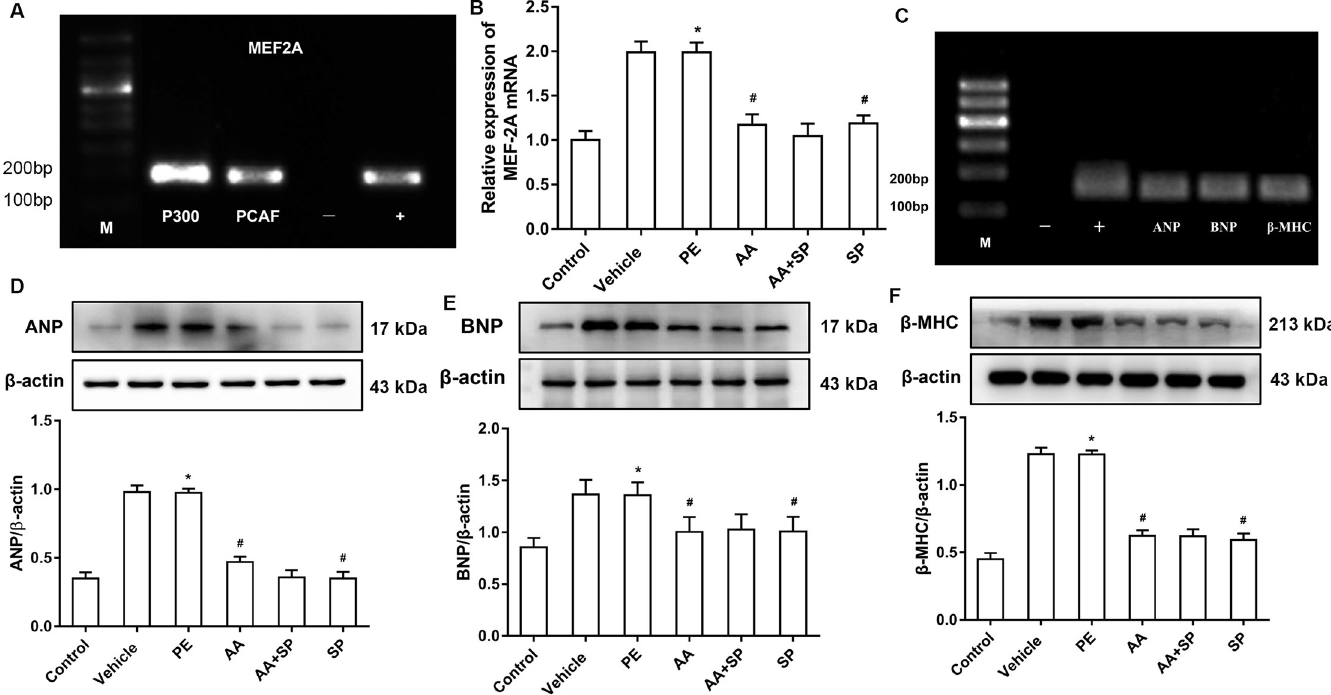
Fig 5. Effects of anacarddic acid (AA) and the JNK inhibitor SP600125 on the expression of cardiac hypertrophy-related genes in phenylephrine (PE)-induced hypertrophic cardiomyocytes. (A) Chromatin immunoprecipitation (ChIP)-PCR results demonstrating the binding of P300 and PCAF to the MEF2A promoter. ( − ) negative control, amplification of DNA fragments after precipitation with normal mouse IgG; (+) positive control, amplification of DNA fragments after precipitation with anti-RNA polymerase II antibody. (B) qRT-PCR results showing that the mRNA expression of MEF2A was higher in PE-induced hypertrophic cardiomyocytes than in control cardiomyocytes, whereas histone acetyltransferases (HATs) and JNK inhibition with AA and SP600125, respectively, prevented MEF2A overexpression in these cells. (C) ChIP-PCR demonstrated that MEF2A could bind to the promoters of cardiac hypertrophy-related genes atrial natriuretic peptide ( ANP ), brain natriuretic peptide ( BNP ), and beta-myosin heavy chain ( β -MHC ). (+): positive control,amplification of DNA fragments after precipitation with anti-RNA polymerase II antibody. (-): negative control, amplification of DNA fragments after precipitation with normal mouse IgG. (D, E, and F) Western blotting showing that expression of the cardiac hypertrophy-related proteins ANP, BNP, and β -MHC was higher in the PE group than in the control group, whereas the HATs inhibitor AA or the JNK inhibitor SP600125 counteracted this effect. � P < 0.05 vs . the control group, # P < 0.05 vs . the PE group (n = 6). M: marker; PE: phenylephrine; DMSO: dimethylsulfoxide; AA: anacardic acid; SP: SP600125 (JNK inhibitor). Figure created in IBM SPSS version 25 (https://www.ibm.com/analytics/spss-statistics-software). The images in this figure were analyzed using Quantity One software Version 4.4